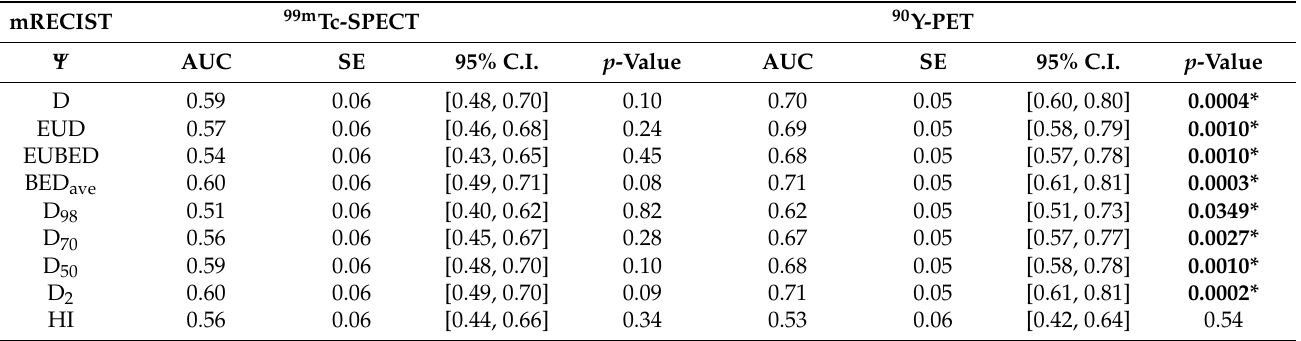
Table 8. AUC values obtained with the densitometric method. The p -values are statistically significant for post-therapy evaluations for all dosimetric variables, except for